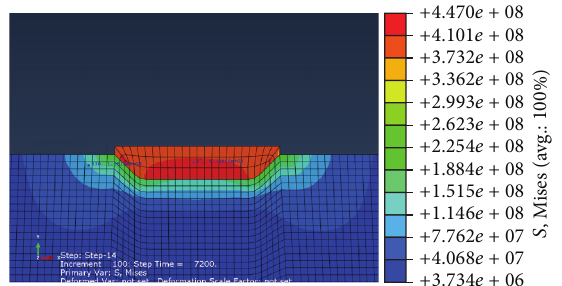
Figure 8: von Mises residual stress at the end of 7 thermal cycles, after